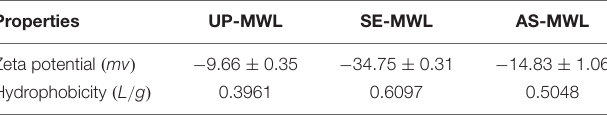
TABLE 5 | The zeta potential and hydrophobicity of lignin